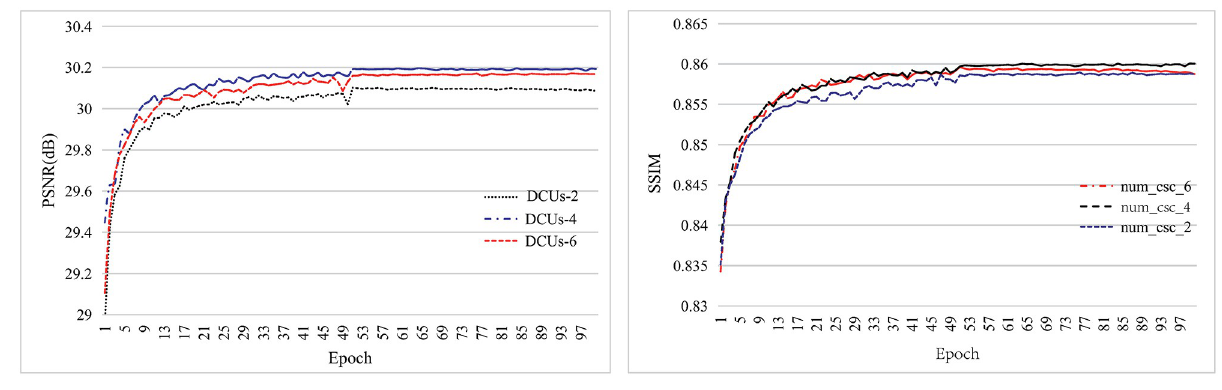
Fig 3. The PSNR and SSIM of the different number of stacked DCUs.